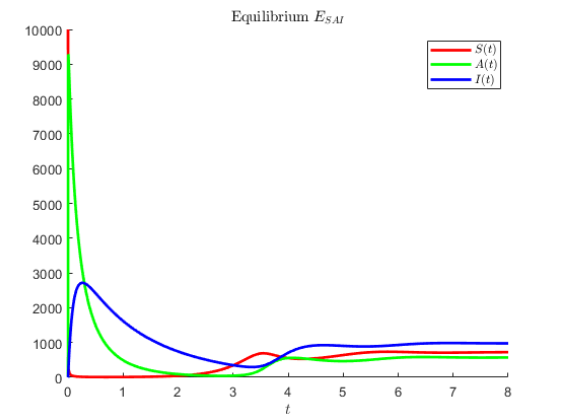
Figure 7. Coexistence equilibrium for model (23) obtained with parameter values (58), (51) and initial conditions